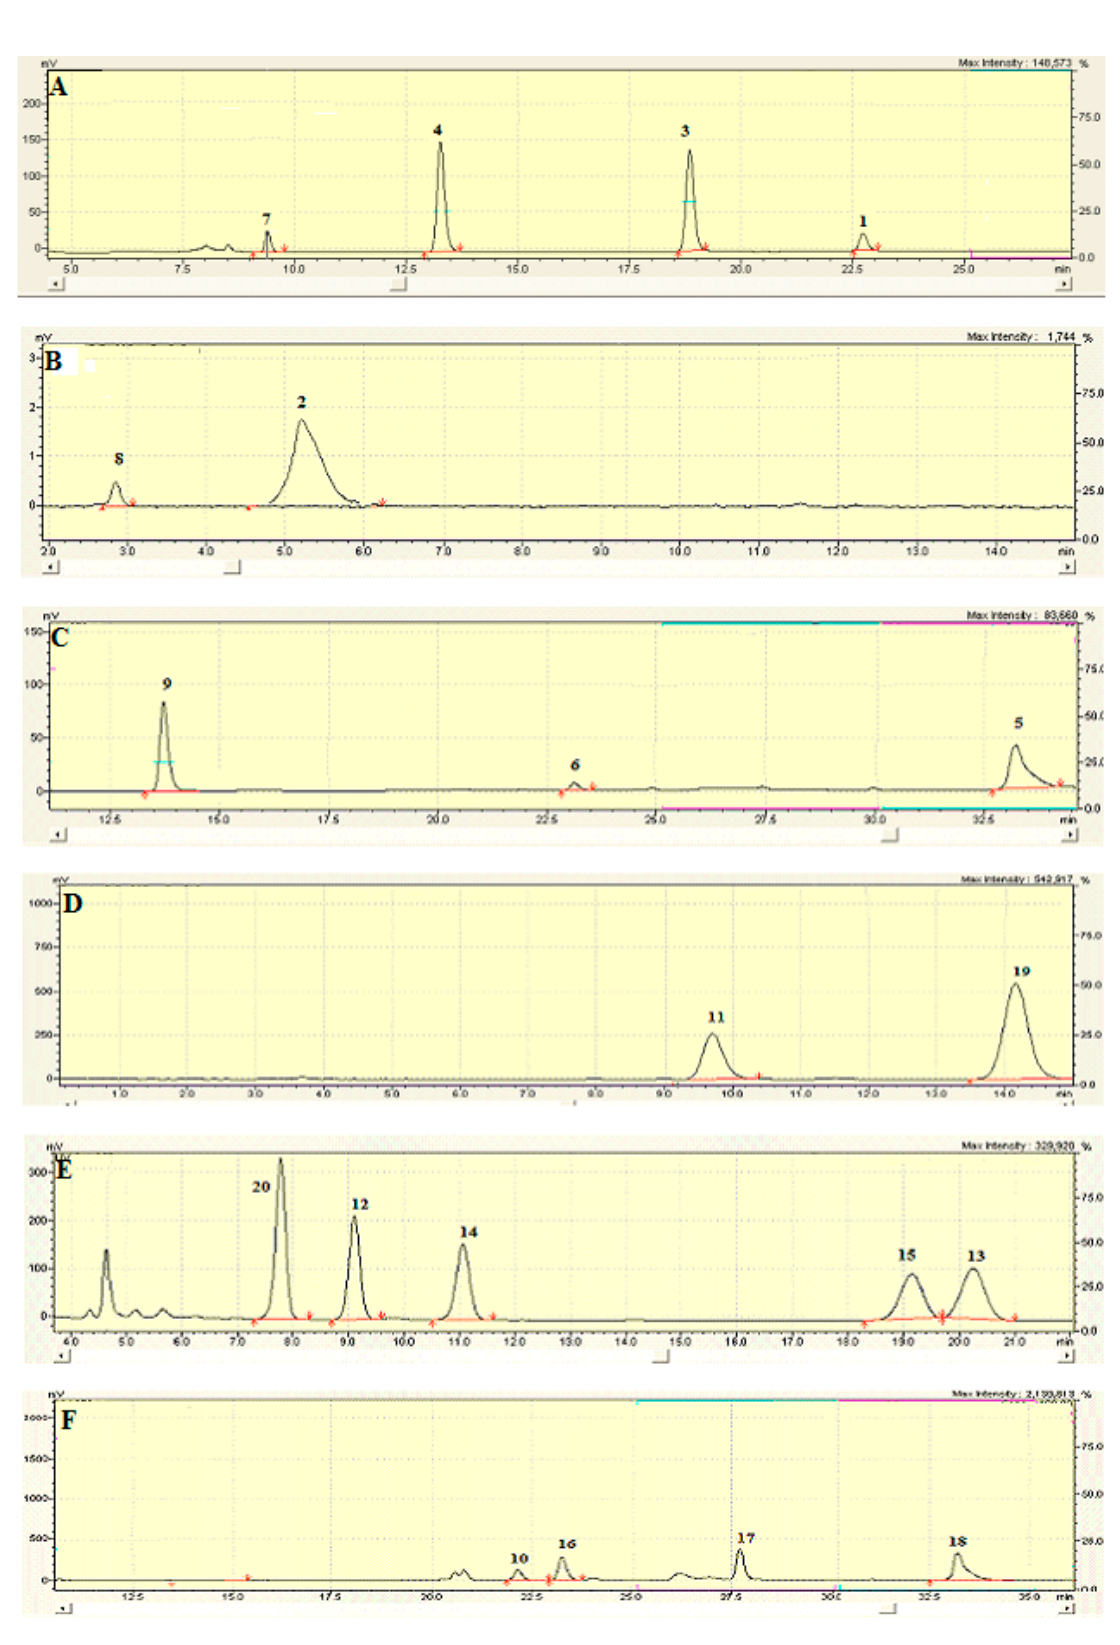
Figure A3. HPLC profiles of compounds isolated from C. coggygria : ( A – F ) fractions Nf1, Nf3, Nf5, Nf6, WW and WM, respectively.